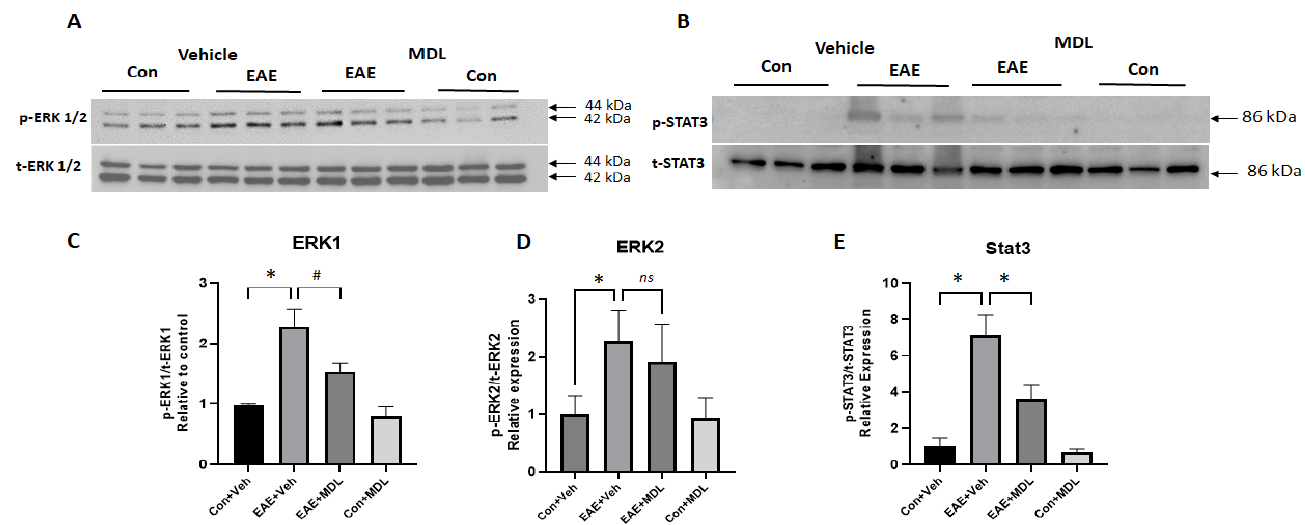
Figure 9. Changes in signaling pathways in the EAE retina. ( A , B ) Western blot studies showing upregulated levels of p-ERK1/2 and downregulation of p-STAT3 in the EAE retina. These changes are reversed in response to MDL 72527 treatment. ( C – E ) Quantitative analysis of western blots demonstrating increased levels of p-ERK1/2 and reduced levels of p-STAT3 in the vehicle-treated EAE retina compared to the control. SMOX inhibition altered the EAE-induced increase in p-ERK1 levels and normalized p-STAT3 levels. Data are presented as mean ± SD. * p < 0.01; # p < 0.05. n = 5–8 per group, and representative images are presented.